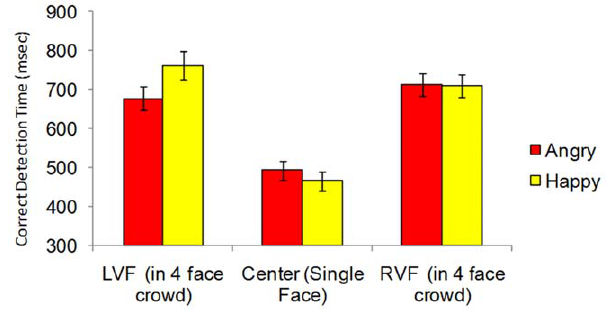
Figure 2. Reaction times to correctly identify the stimulus as a function of the type of dynamic expression (becoming angry vs. becoming happy) and its location. Standard error bars are included to provide a sense of variability across subjects, but do not correspond to the within-subjects hypothesis tests reported in the text. Experiment 2